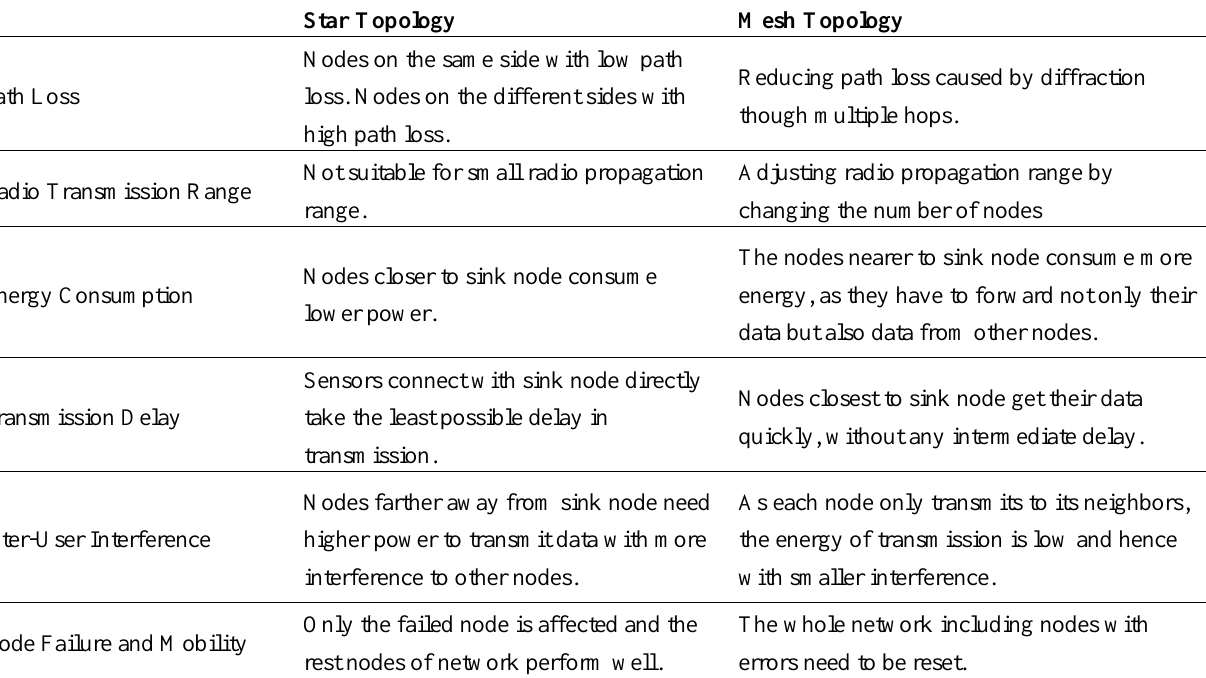
Table 2. A comparison between star topology and mesh